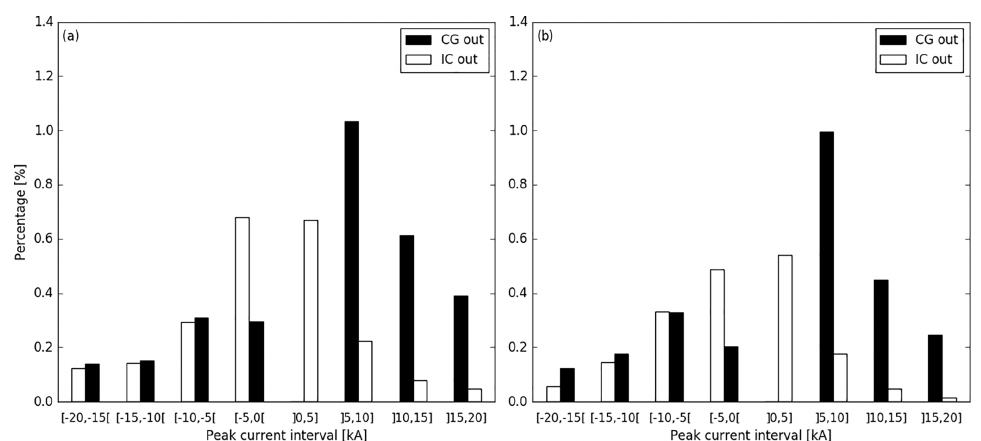
Figure 8. Percentage of outliers as a function of peak current in (a) Belgium and (b) Austria for a search radius of 2km.